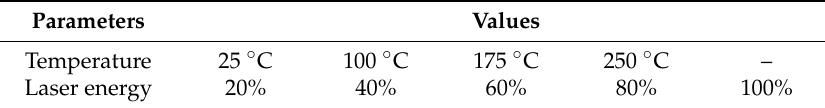
Table 3. The experimental